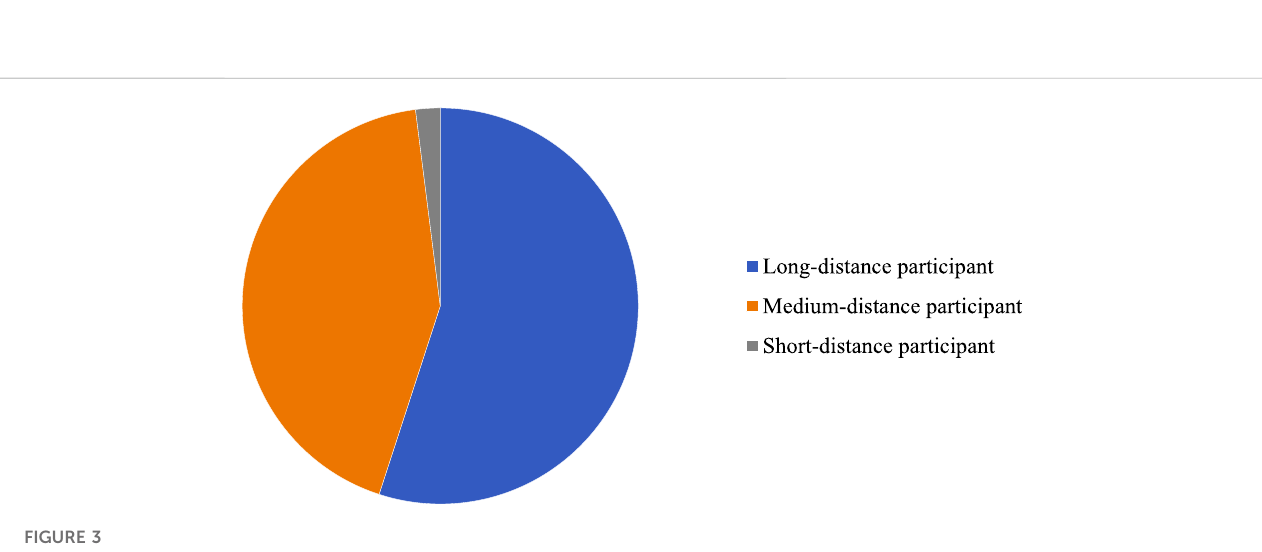
default value of the emission coef fi cient of the j th vehicle, and the unit is ton/km. AD Wn is the activity data on the n th waste treatment method whoseunitiskg. E W referstogreenhousegasemissionsofwastedisposed.